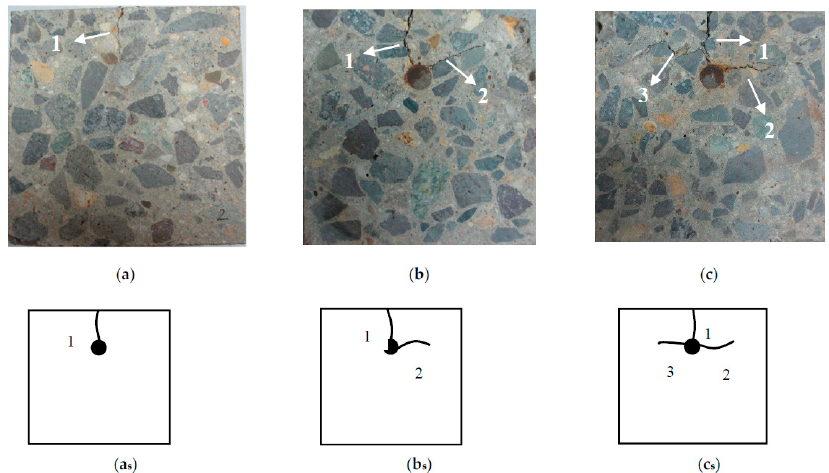
Figure 3. Cracking patterns of corrosion-induced cracks: ( a ) Pattern I; ( b ) Pattern L; ( c ) Pattern T; ( a s ) Simplification of the pattern I; ( b s ) Simplification of the pattern L; ( c s ) Simplification of the pattern T. (Sequence numbers in figures indicate the appearance order of cracks).